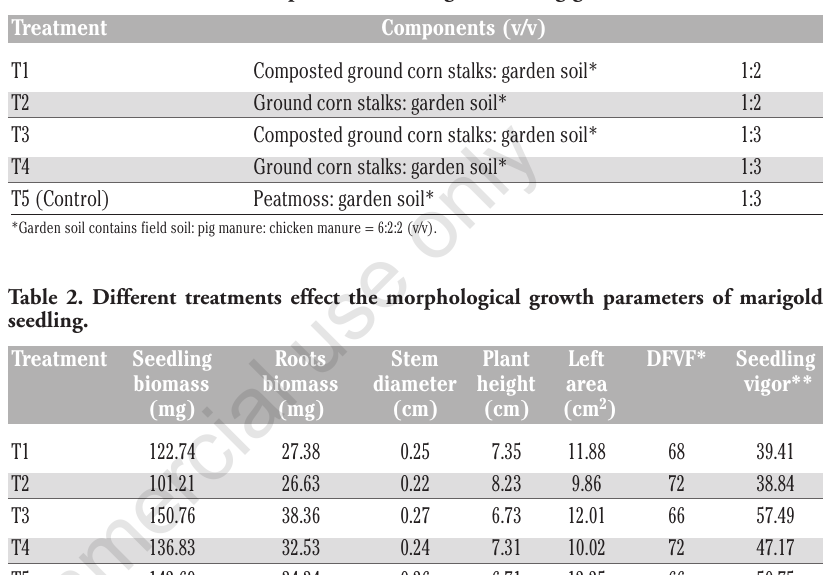
Table 1. Substrate and its components for marigold seedling growth.